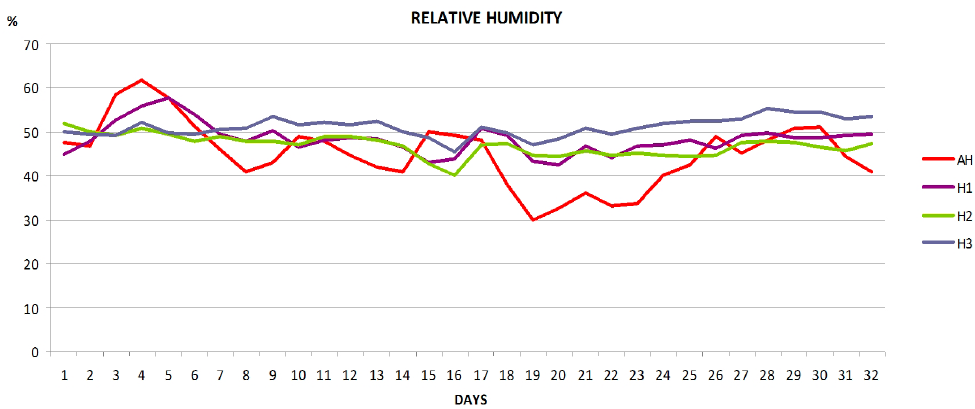
Figure 20. Average humidity per day of four hives over 32 days. Humidity was registered at ambient (AH) and three areas inside the beehives: brood area (H1), area with honey/pollen reserves of in the periphery of the brood comb (H2), and in honeycombs (H3).